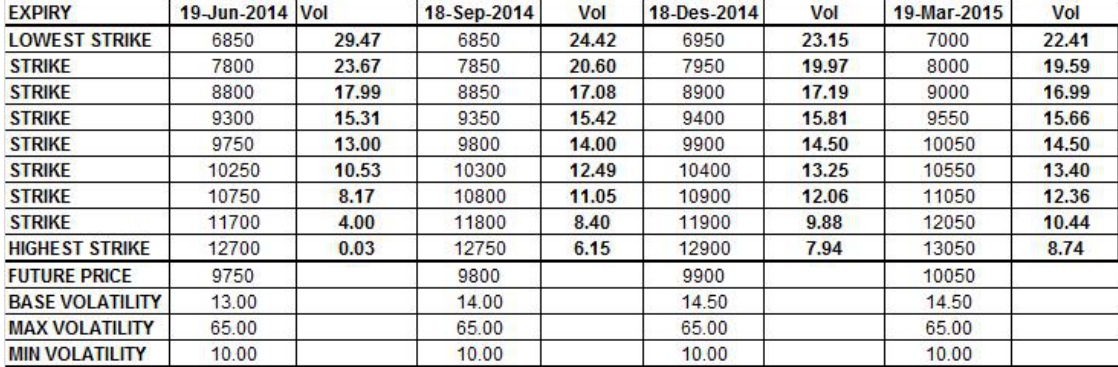
DTOP Please define if necessary volatility surface as published by the Johannesburg Stock Exchange (JSE) on 28 May